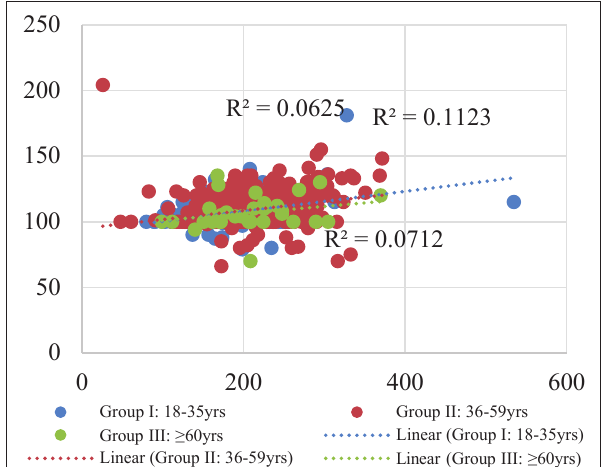
Fig-3: Correlation between Device method and laboratory method according to Age